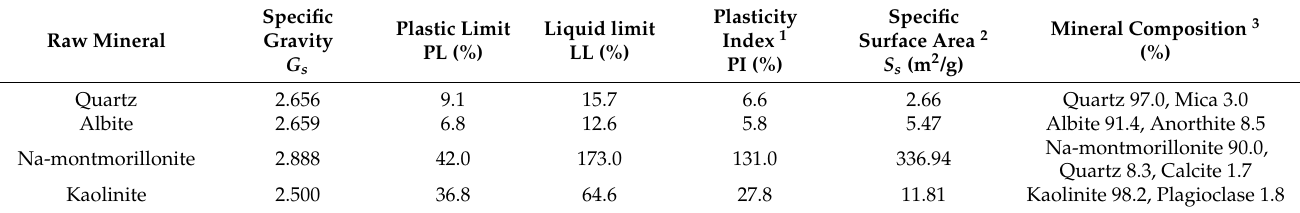
Table 4. The basic physical properties of raw